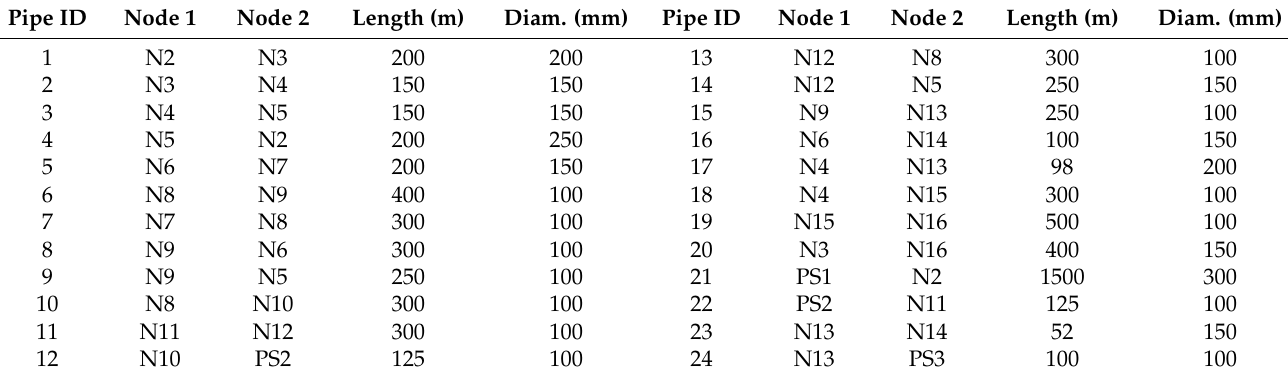
Table 2. Case study network: pipeline information.